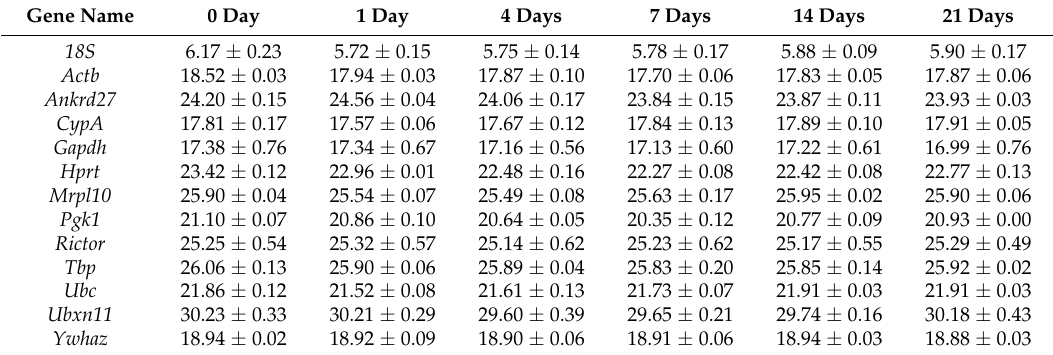
Table 3. Raw CT values of dorsal root ganglion (DRG) samples at 0, 1, 4, 7, 14, and 21 days post sciatic nerve crush. (CT values were presented as means ± SEM).